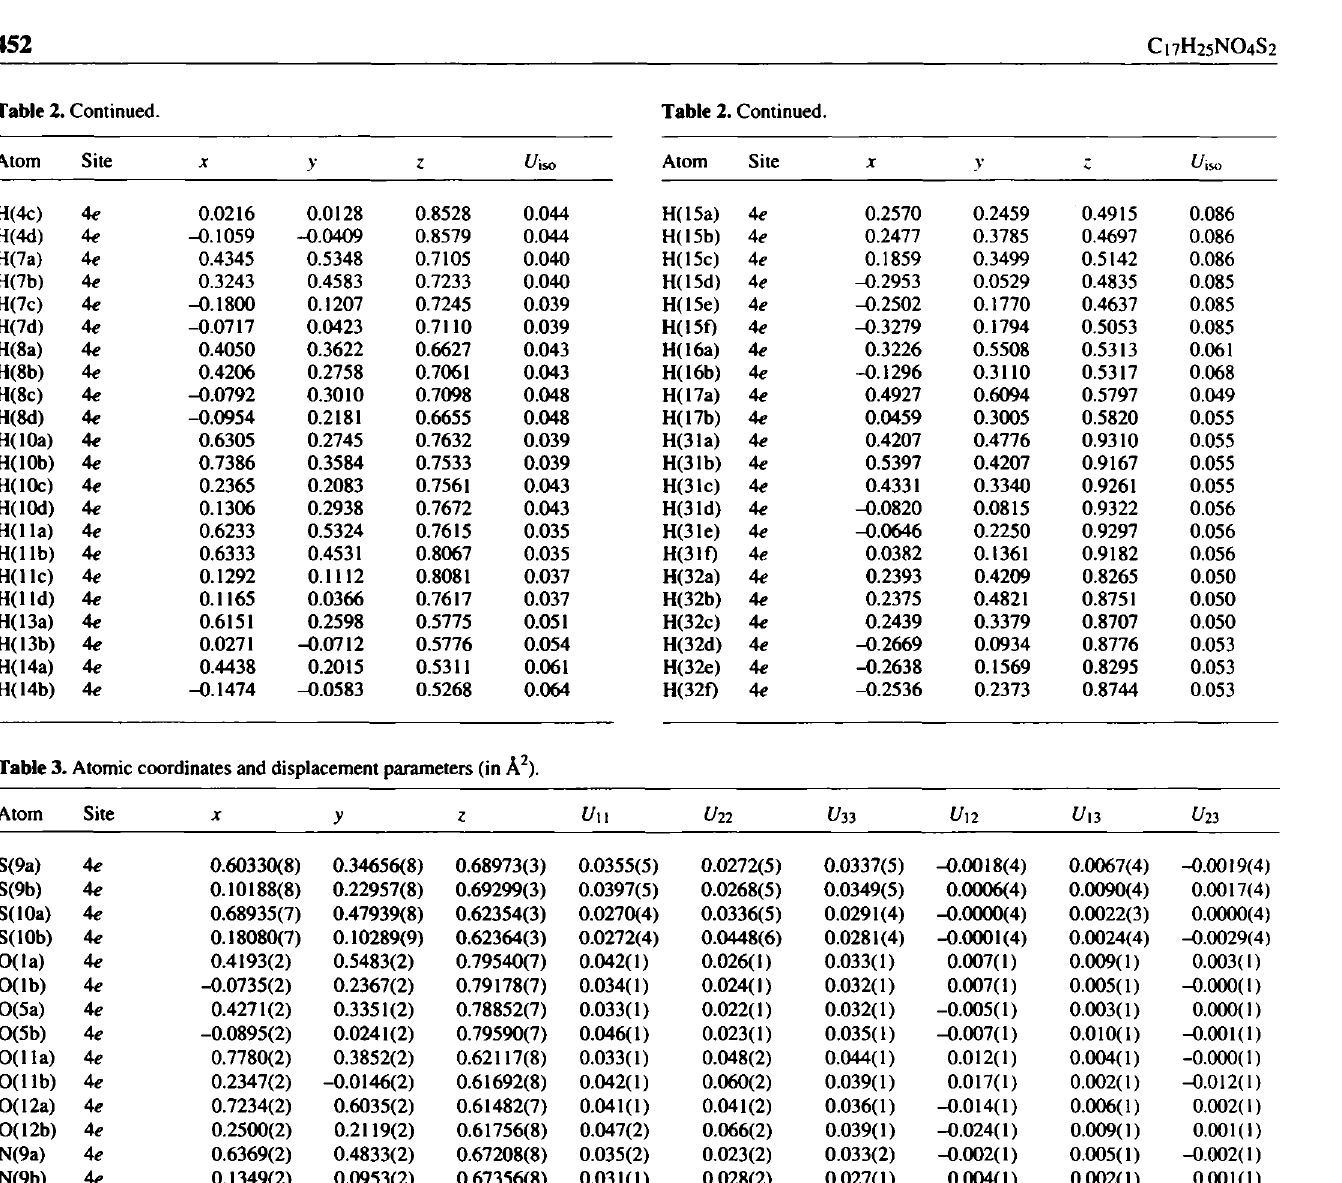
Table 3. Atomic coordinates and displacement parameters (in Ä 2